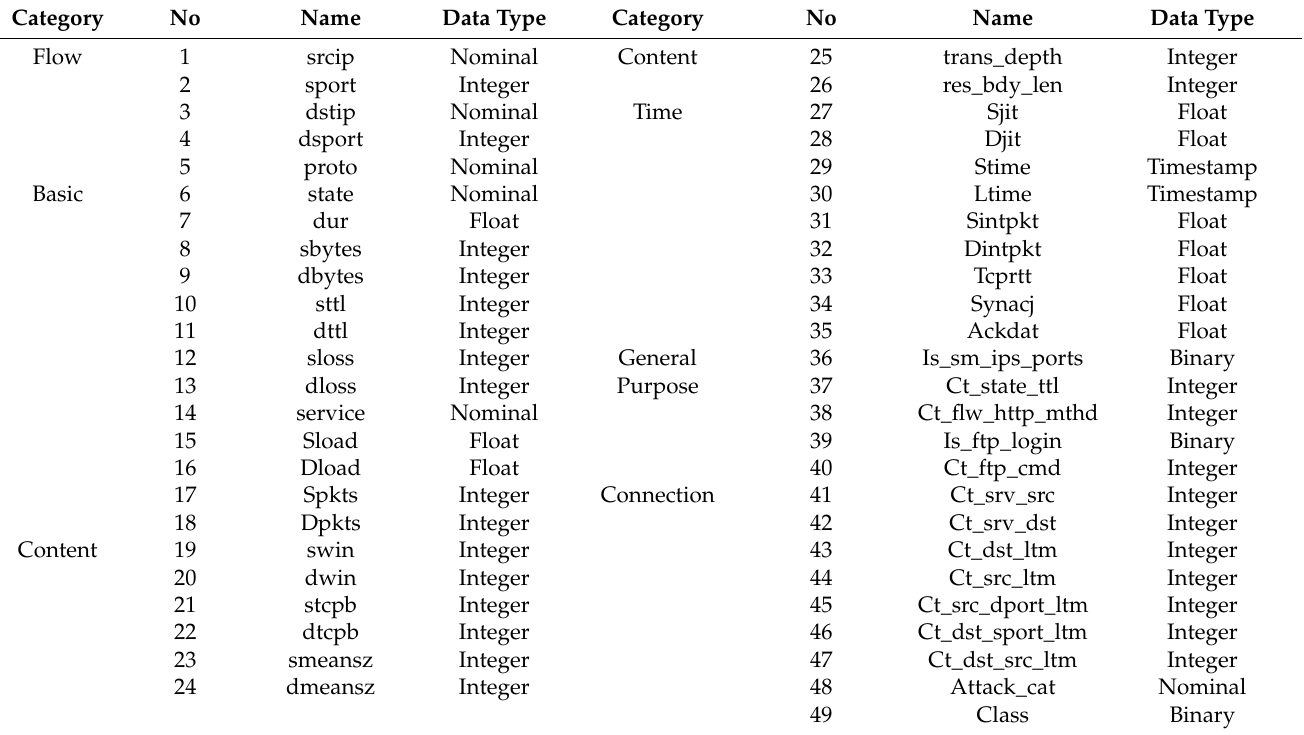
Table 2. UNSW-NB15 Features with their data type and